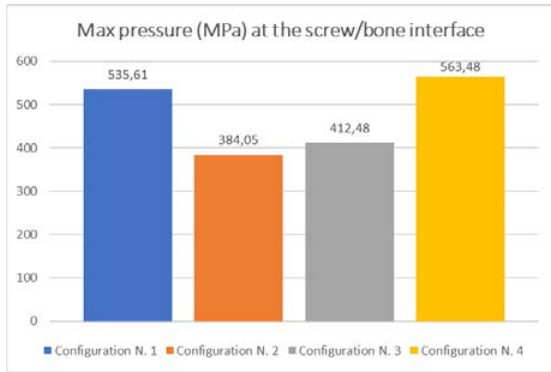
Figure 13. Calculated max pressure values for all configurations.